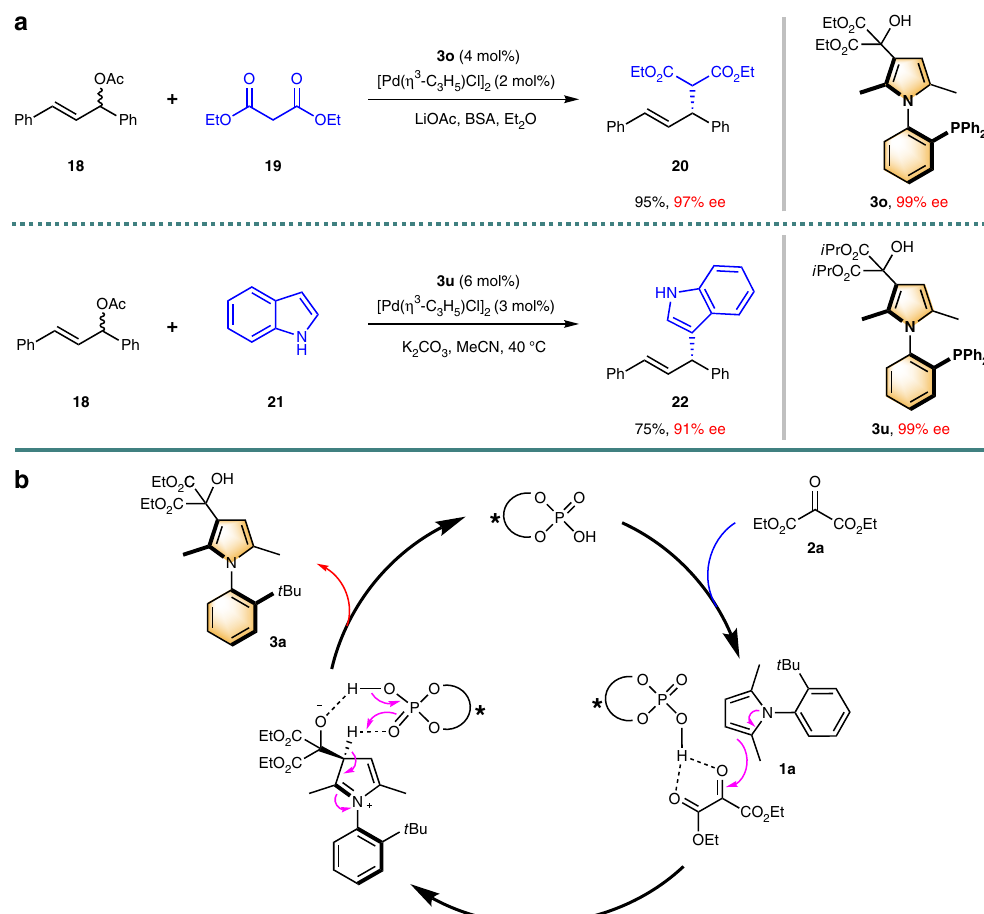
Fig. 4 Applications in asymmetric catalysis and plausible mechanism. a Asymmetric catalysis applications. b Proposed reaction